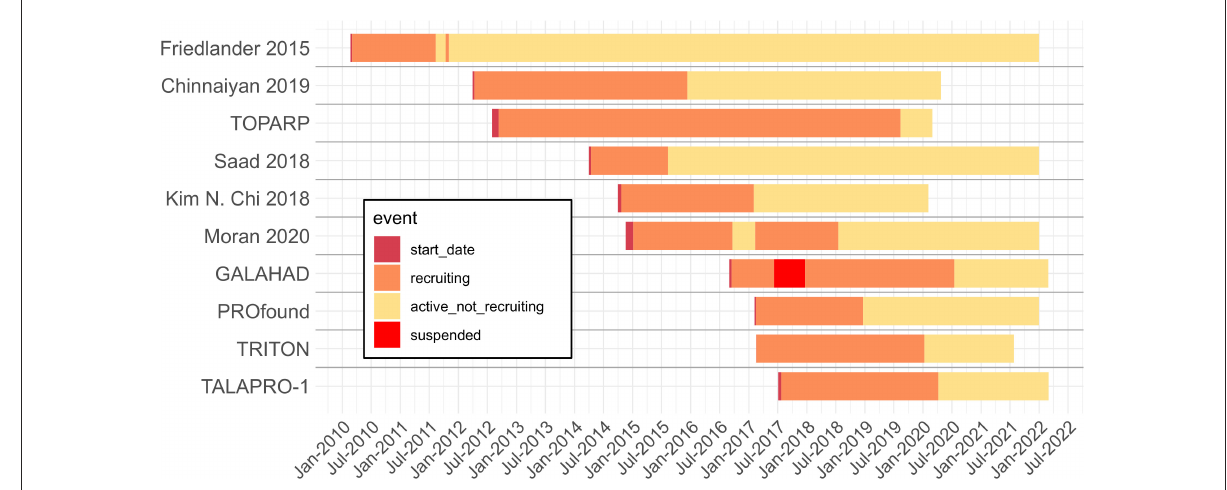
FIGURE2 Timeline of reviewed trials with start, recruiting, active not recruiting and suspended dates extracted from Clinicaltrials.gov archive. When trials have not been completed, end dates are given by the Clinicaltrials.gov expected completion date. Dotted line is the extraction date.